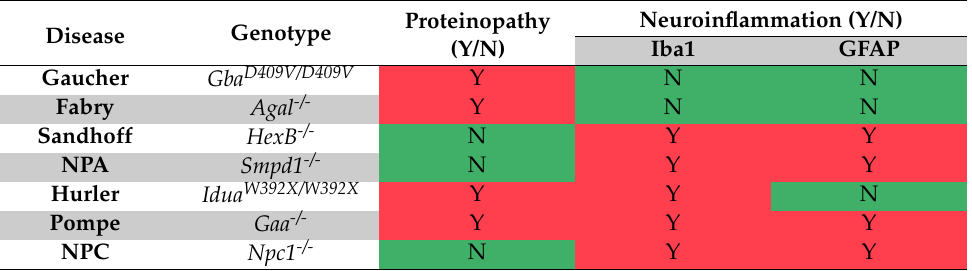
Table 4. Summary of detectable proteinopathy and neuroinflammatory markers in brains of LSD model